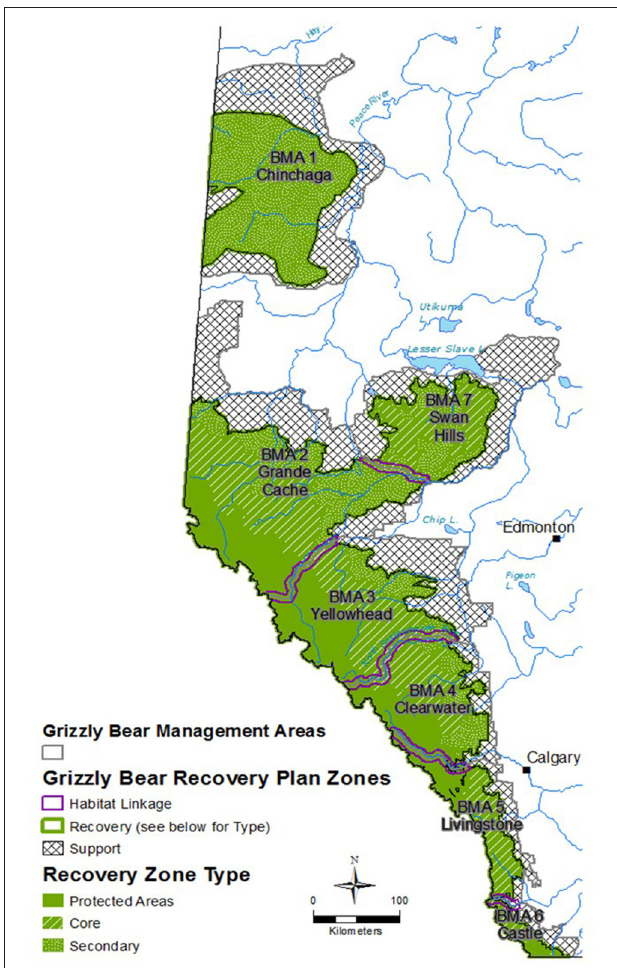
FIGURE 1 | Provincial map of Alberta with bear management areas (BMA), recovery and support recovery zones (Alberta Environment Parks, 2020).